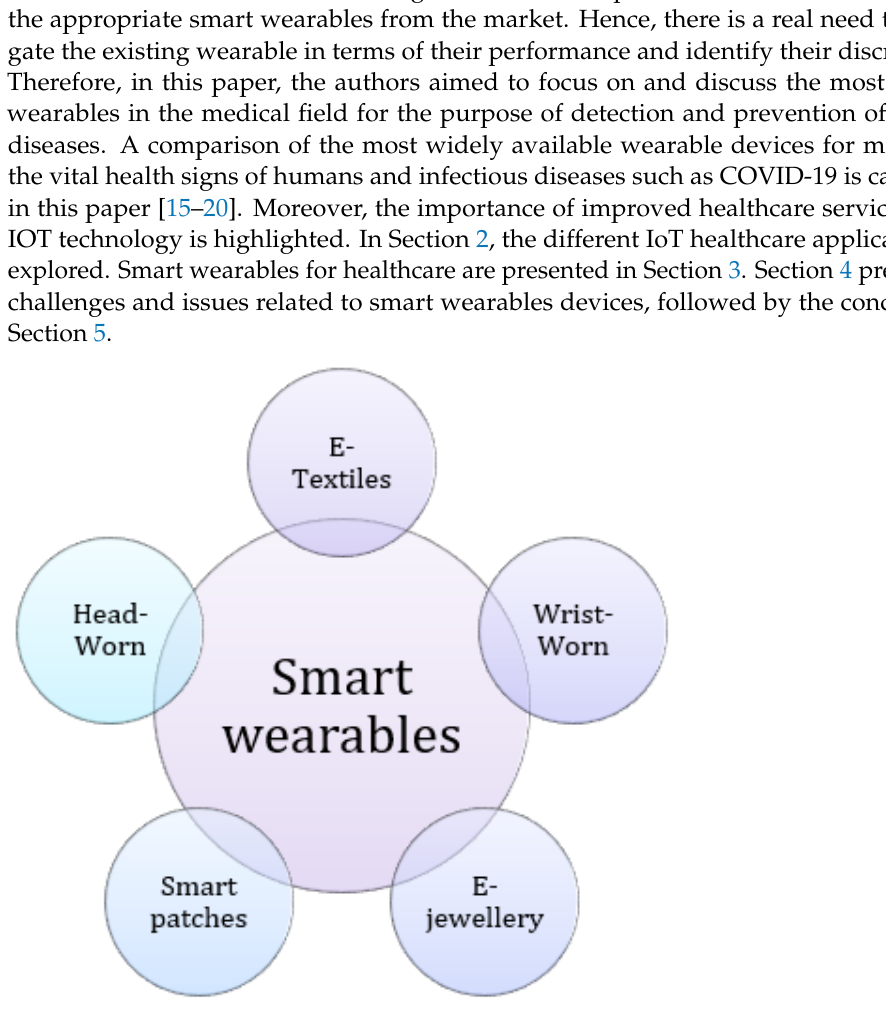
Figure 2. Categorization of wearable